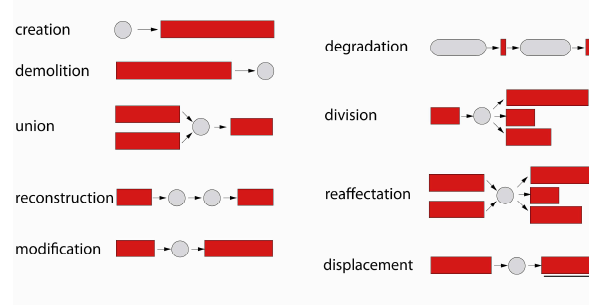
Figure 8. Temporal notation for the description of building